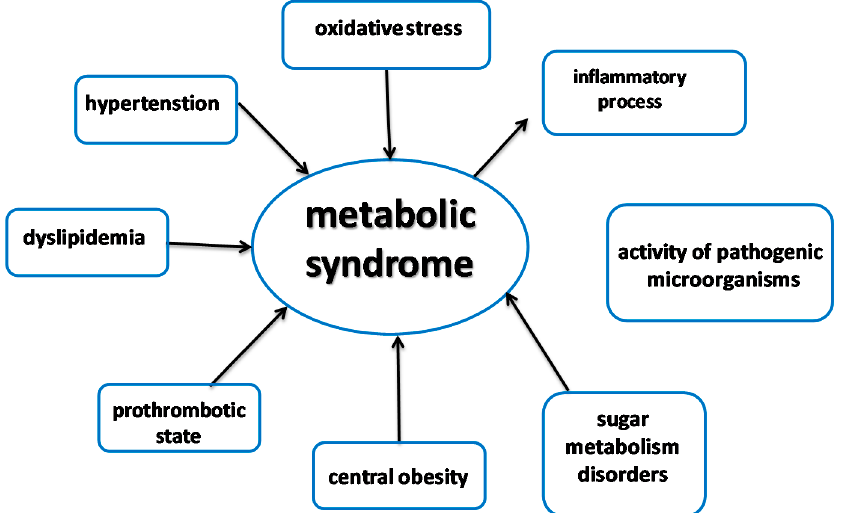
Figure 3. Risk factors of metabolic syndrome.